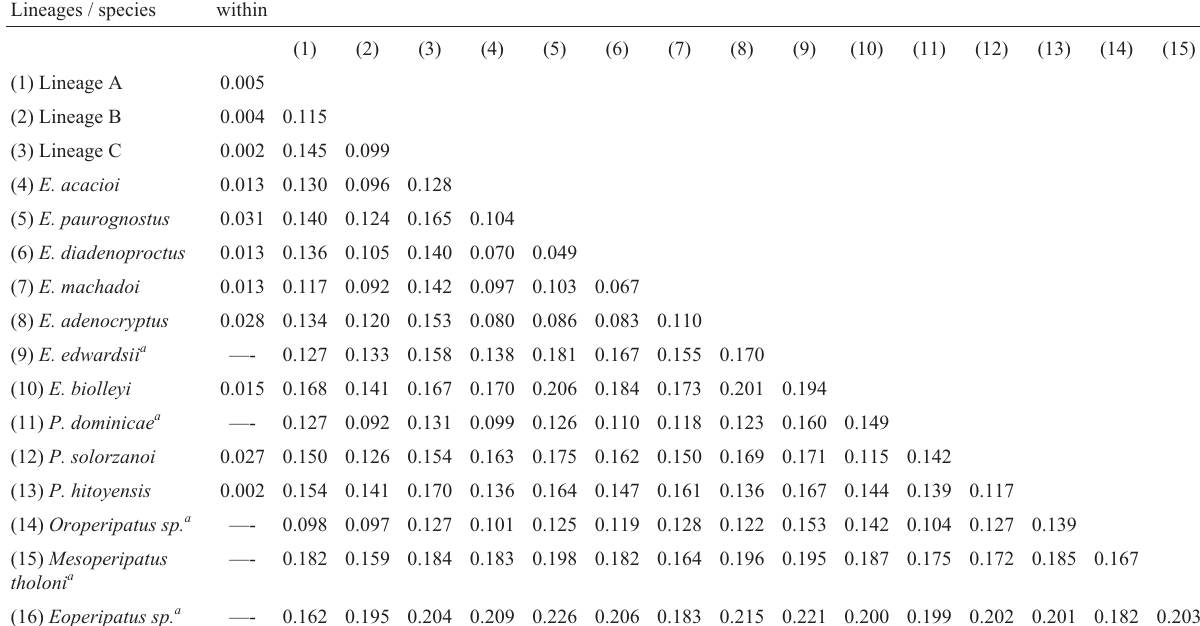
Table 1 - The p -distances recorded within and between the lineages and species analyzed in the present study based on sequences of the mitochondrial COI gene. Lineages /